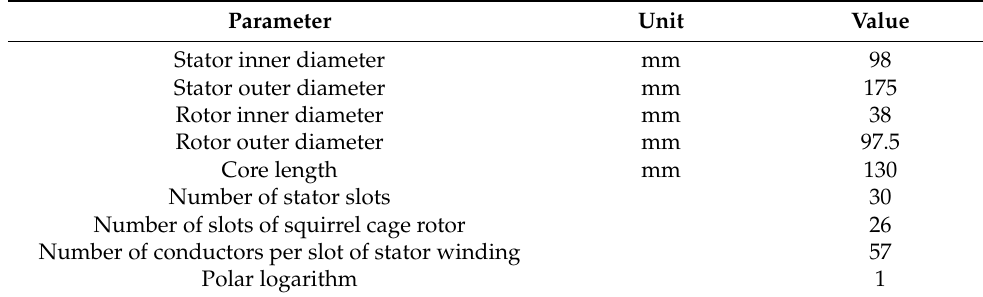
Table 2. Experimental parameters of five − phase induction motor.